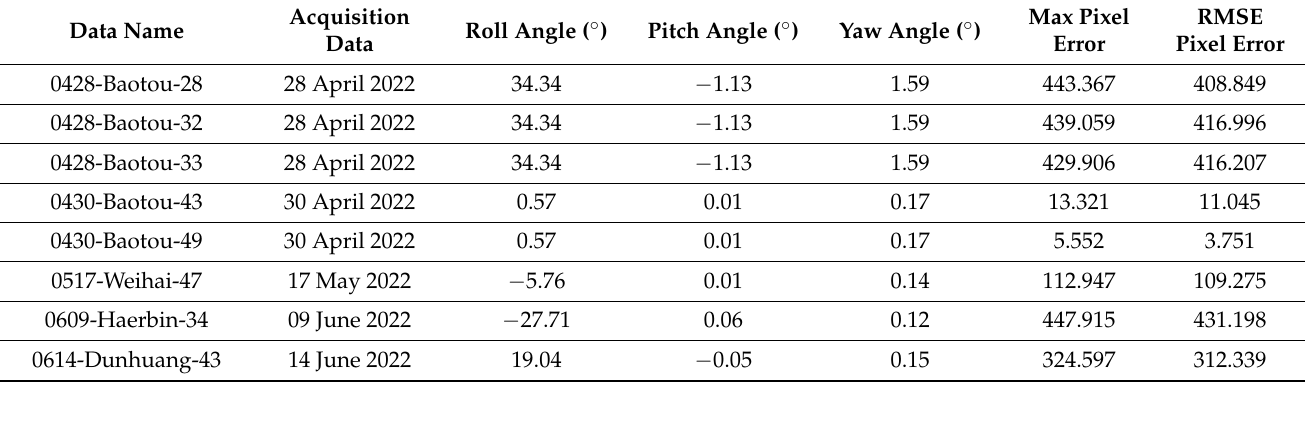
Table 2. Validation of image geometric accuracy.